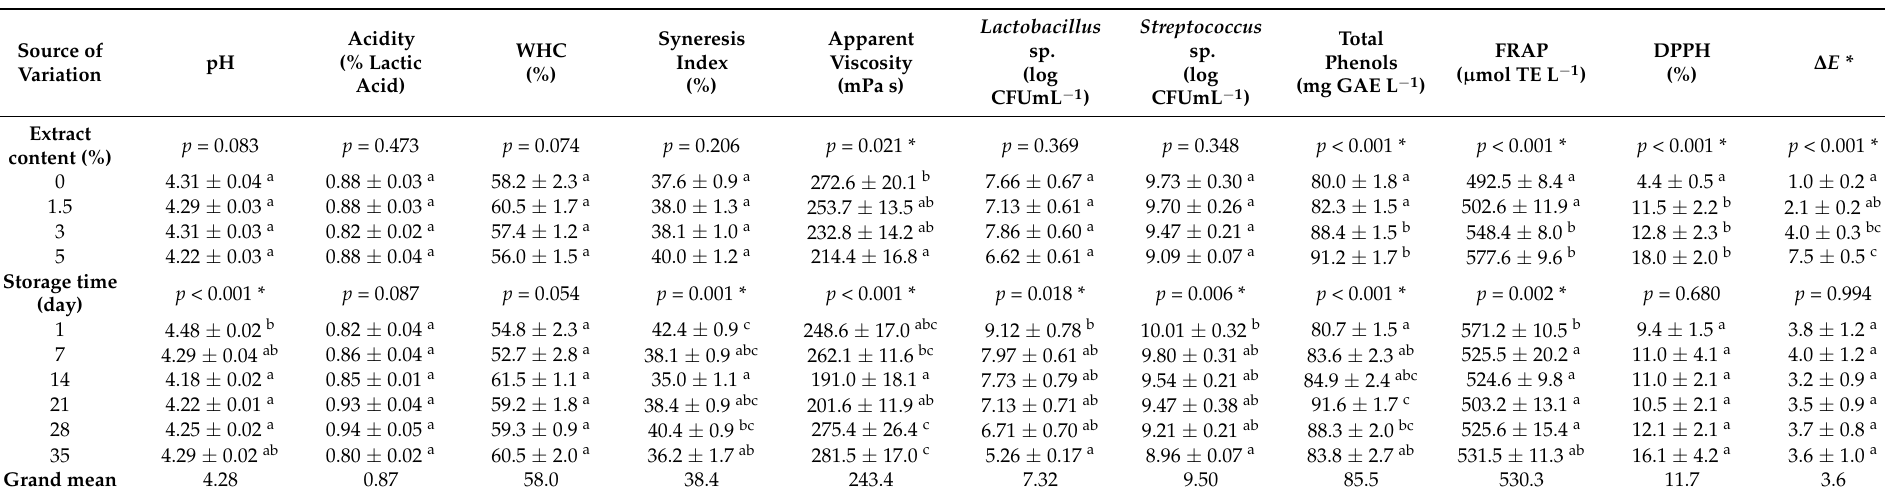
Table 2. Influence of extract content (%) and storage time on physical, chemical, and microbiological properties of yoghurts enriched with olive leaf